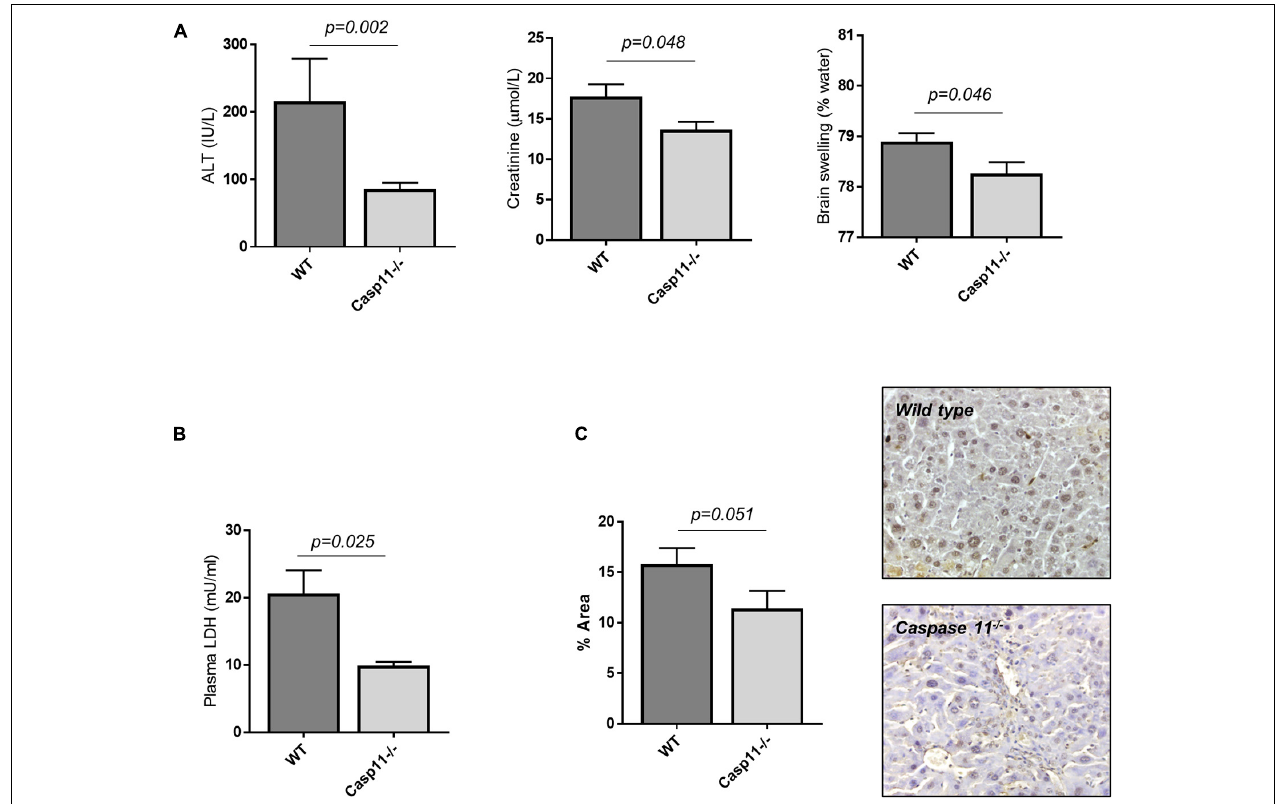
FIGURE 4 | Caspase-11 deficiency protects from hepatic and extra-hepatic organ injury in ACLF. Wild type and c asp11 - / - type mice were treated with CCl 4 (0.5ml/kg, 20 doses) to develop advanced hepatic fibrosis, and subsequently injected i.p., with LPS (4 mg/kg). (A) 4 h following LPS injection, Casp11 - / - mice ( n = 6) displayed significantly lower ALT (Student’s t -test, p = 0.002), creatinine (Student’s t -test, p = 0.048), and brain tissue water content (Student’s t -test, p = 0.046) than wild type ( n = 8). (B) Lower levels of cell death were also reflected in reduced levels of plasma LDH (Student’s t -test with Welch correction, p = 0.025). (C) Hepatocyte cell death was assessed by TUNEL assay and quantified by measuring positively stained areas. Casp11 - / - mice displayed lower levels of hepatocyte cell death than wild type (Student’s t -test, p = 0.051).